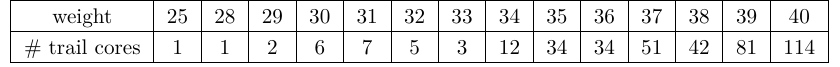
Table 3: 3-round trail core weight histogram. Each unit corresponds to 257 trail cores.